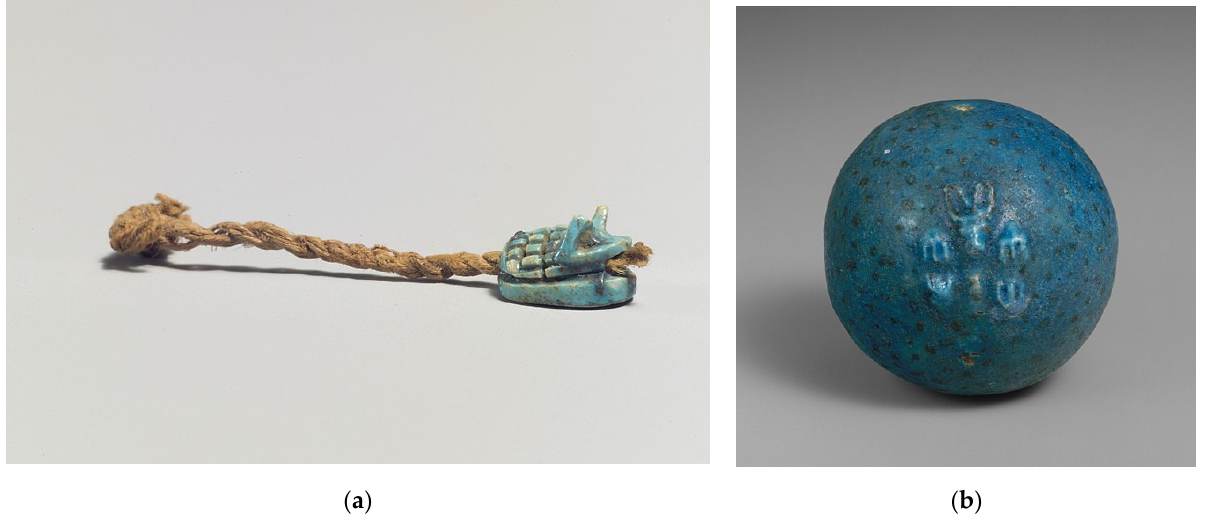
Figure 2. ( a ) Glazed steatite hedgehog amulet on string, mid-13th Dynasty Memphis (Lisht North cemetery, pit 995). Metropolitan Museum of Art, New York (22.1.301). Image in Public Domain. ( b ) Faience spherical modelled hedgehog, 18th Dynasty (location not recorded). Metropolitan Museum of Art, New York (1989.281.91). Image in Public Domain.